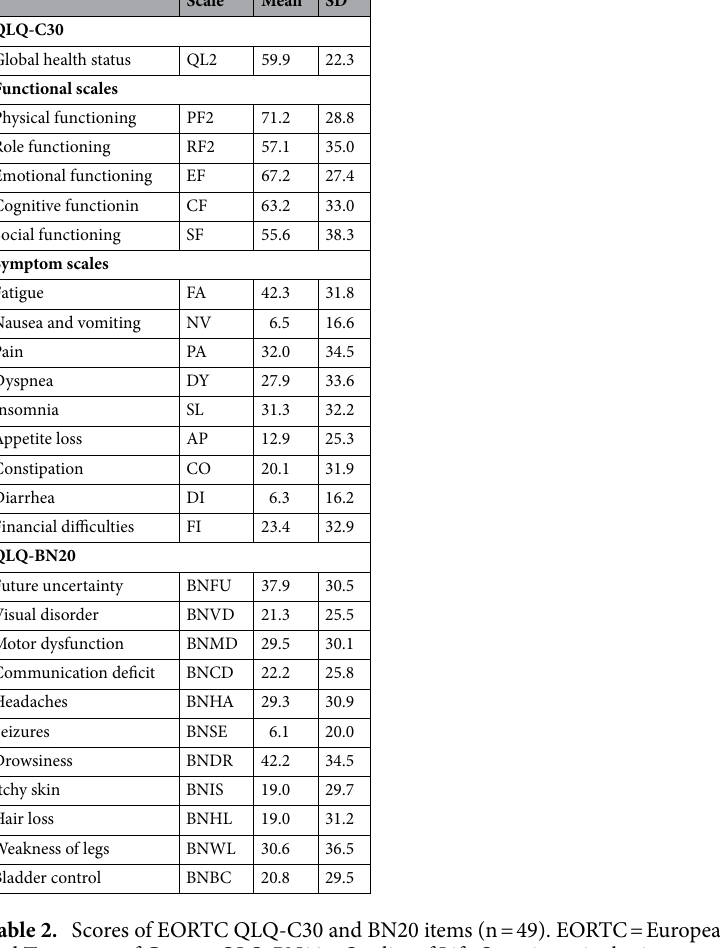
Table 2. Scores of EORTC QLQ-C30 and BN20 items (n = 49). EORTC = European Organisation for Research and Treatment of Cancer; QLQ-BN20 = Quality of Life Questionnaire brain cancer module; QLQ-C30 = Core Quality of Life Questionnaire; SD = standard